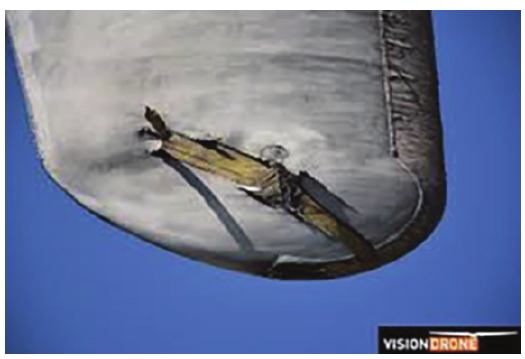
Figure 3. The defined coordinate